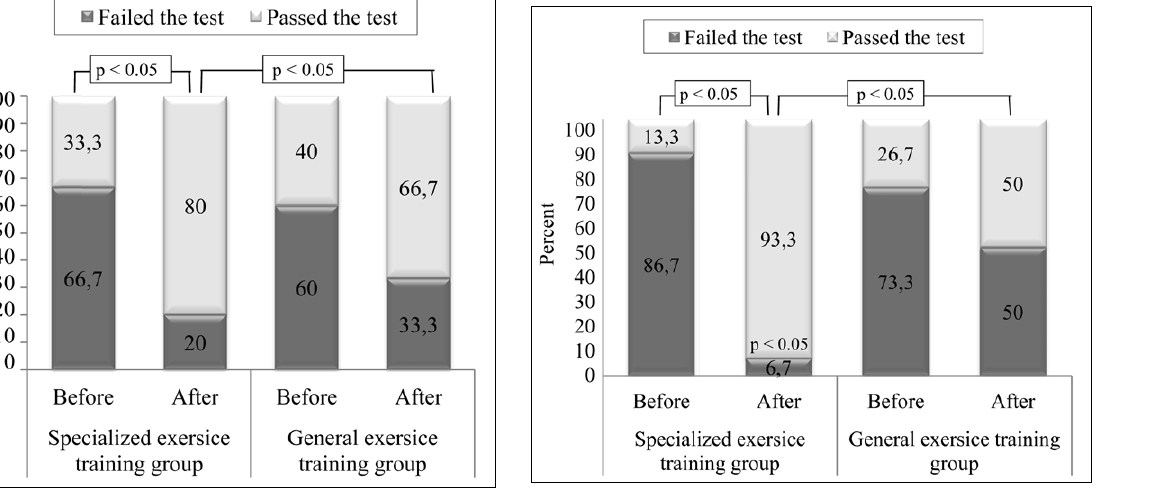
Figure 4. “Pelvic tilt”